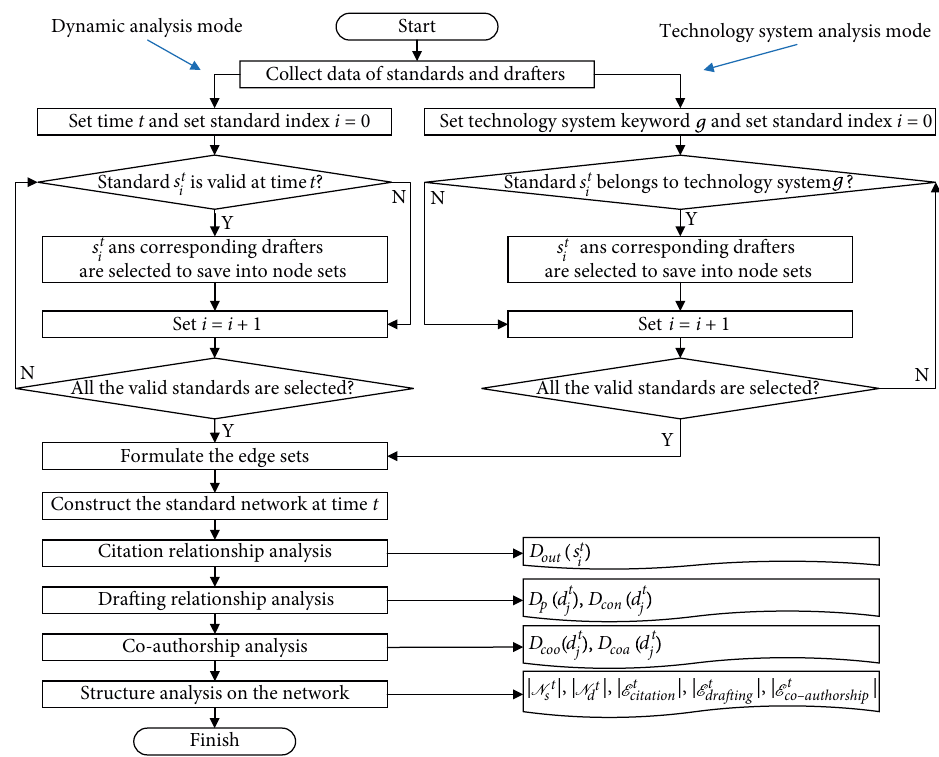
Figure 2: Flowchart depicting the construction of network and computation of